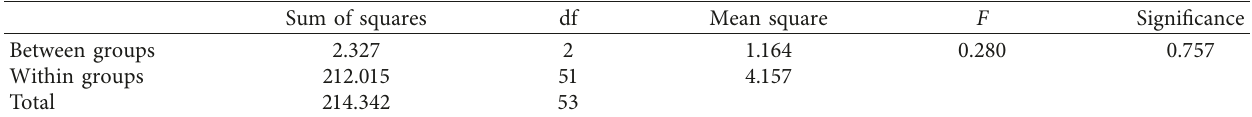
Table 7: One-way ANOVA for the immediate posttest scores.